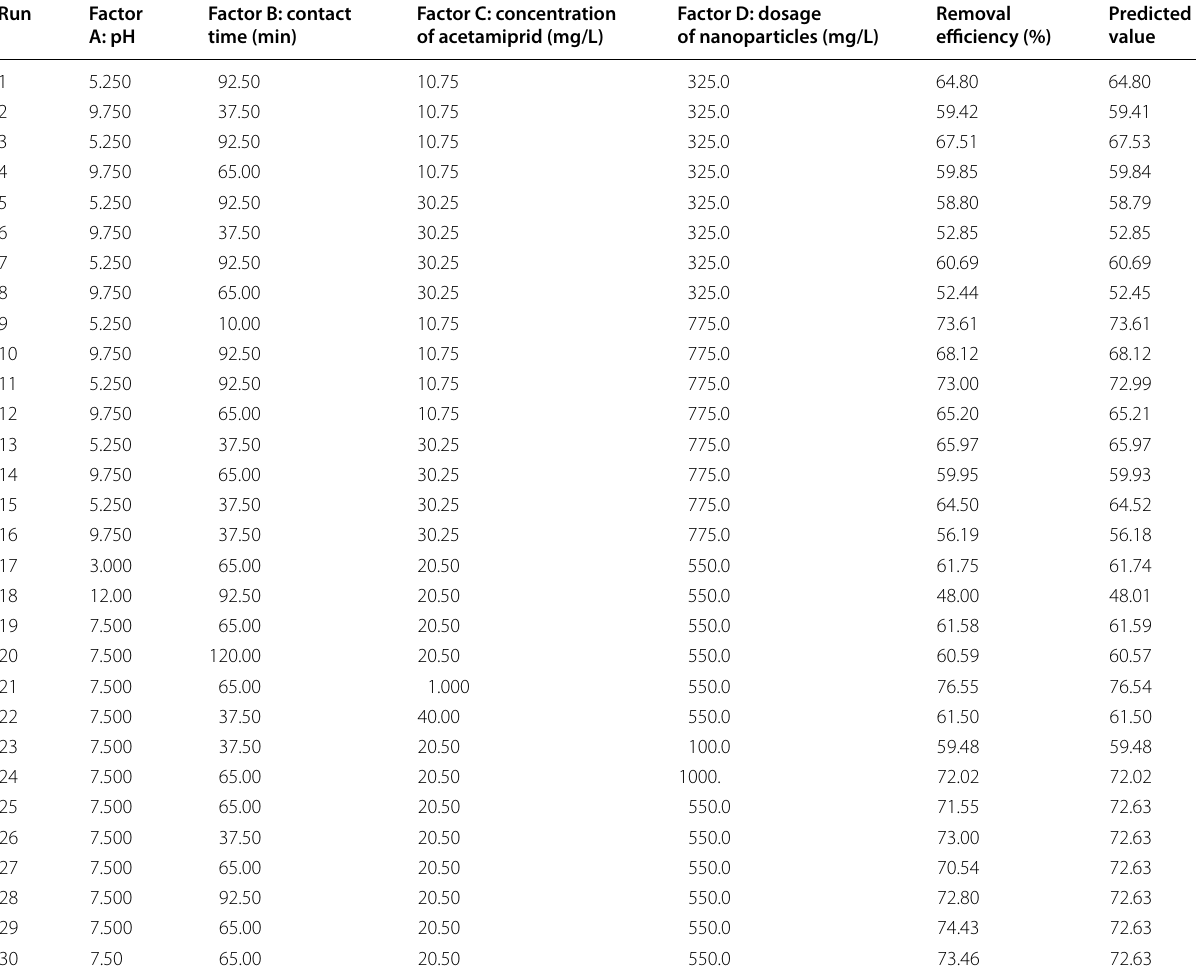
Table 2 Results of the experimental runs designed according to the CCD